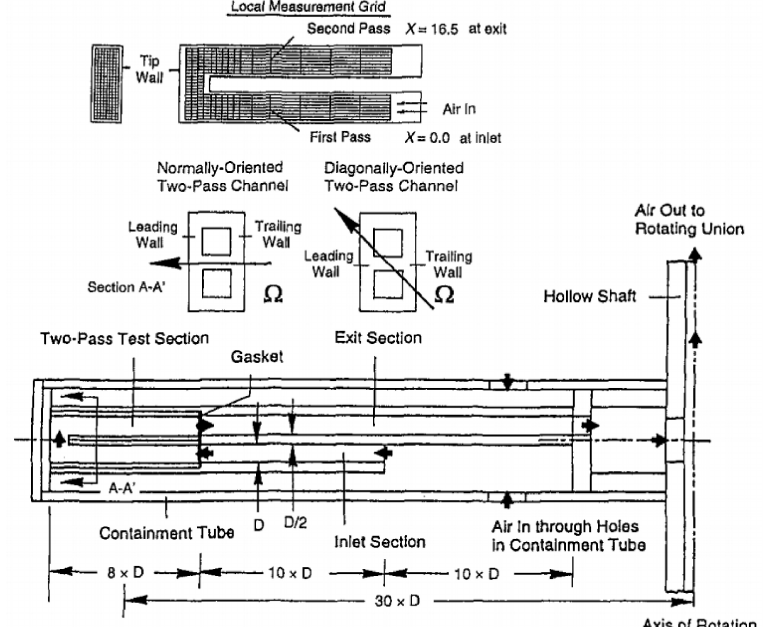
Figure 8. Mass transfer experiments under rotating conditions [35]. Reprint with permission from ASME (order number 1084745).